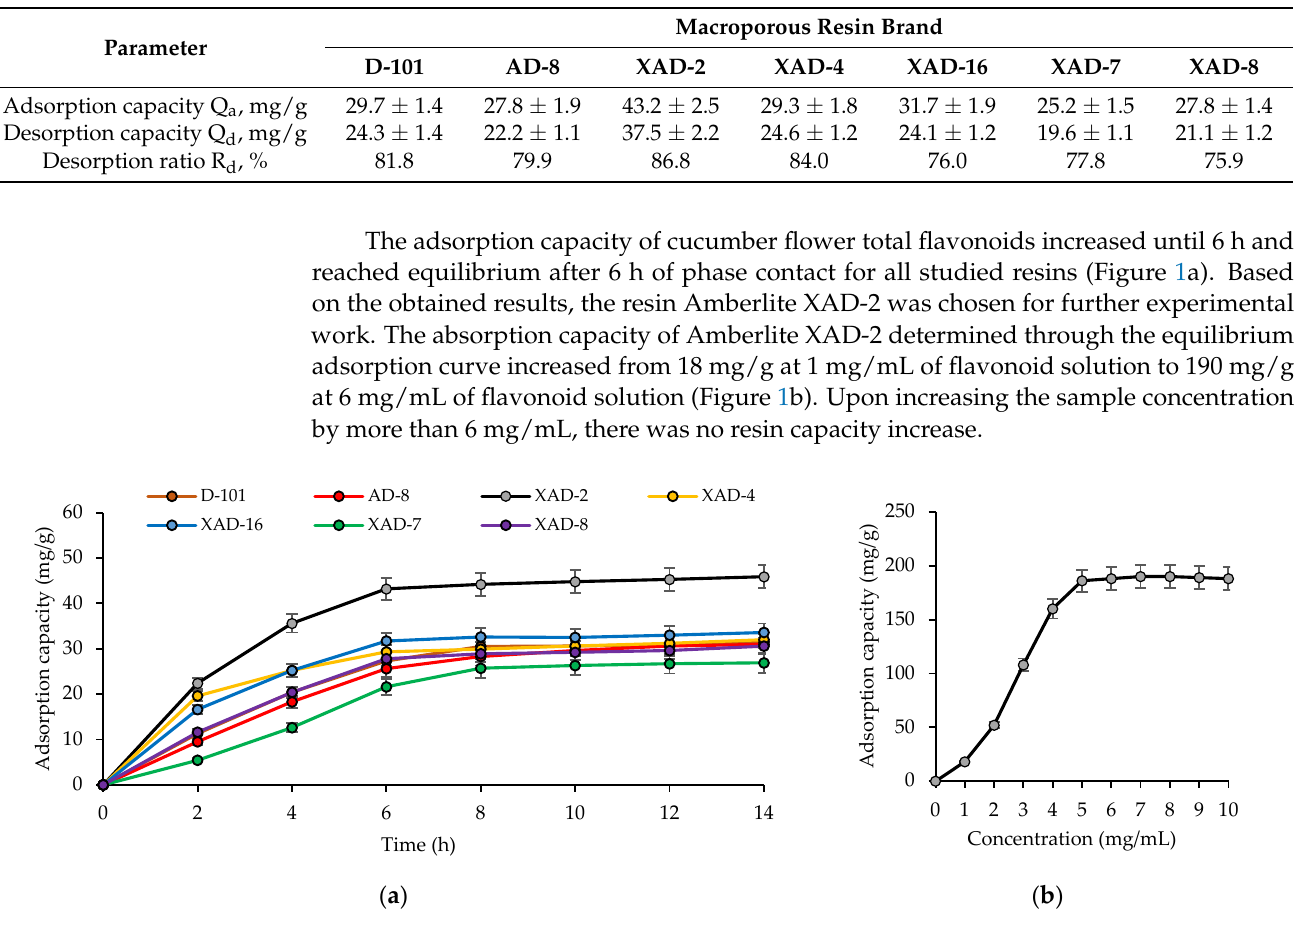
Figure 1. Adsorption curves for total cucumber flower flavonoids on seven macroporous resins ( a ) and equilibrium adsorption curve for total cucumber flower flavonoids on Amberlite XAD-2 ( b ).